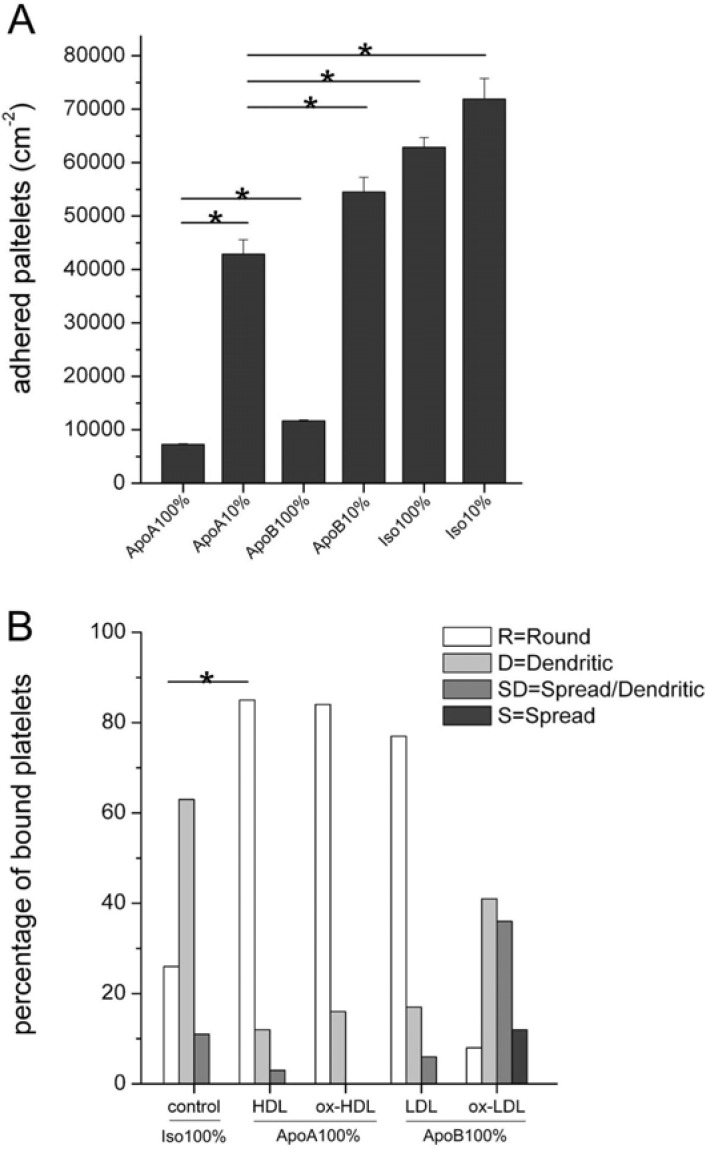

A. Platelet adhesion on coated disks. Platelet adhesion: SEM analysis of adhered platelets on surfaces coated with ApoA-I-, ApoB- or isotype antibody after corresponding pre-treatment. The number of adhered platelets are given as the mean ± SD (n = 3). (* = P<0.05). B. Platelet morphology. The morphology of the adhered platelets was divided into 4 different classes representing various degrees of activation, ranging from “round” (weak), “dendritic” (intermediate), “spread/dendritic” (strong) to “spread” (very strong). The data are presented as the percentage of platelets exhibiting the indicated morphology. Data error bars are the standard deviation of the mean (n = 3).